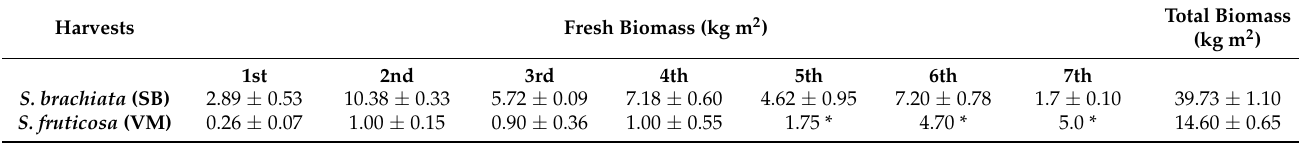
Table 2. Fresh shoot biomass in Salicornia brachiata (SB) and Sarcocornia fruticosa (VM) for seven harvests approximately 40 days apart over one year. Plants were grown under greenhouse conditions and with natural daylight and 9 mM N and 50 mM NaCl. The means plus standard errors ( ± SE) of each harvest are shown, n = 2, * n = 1.